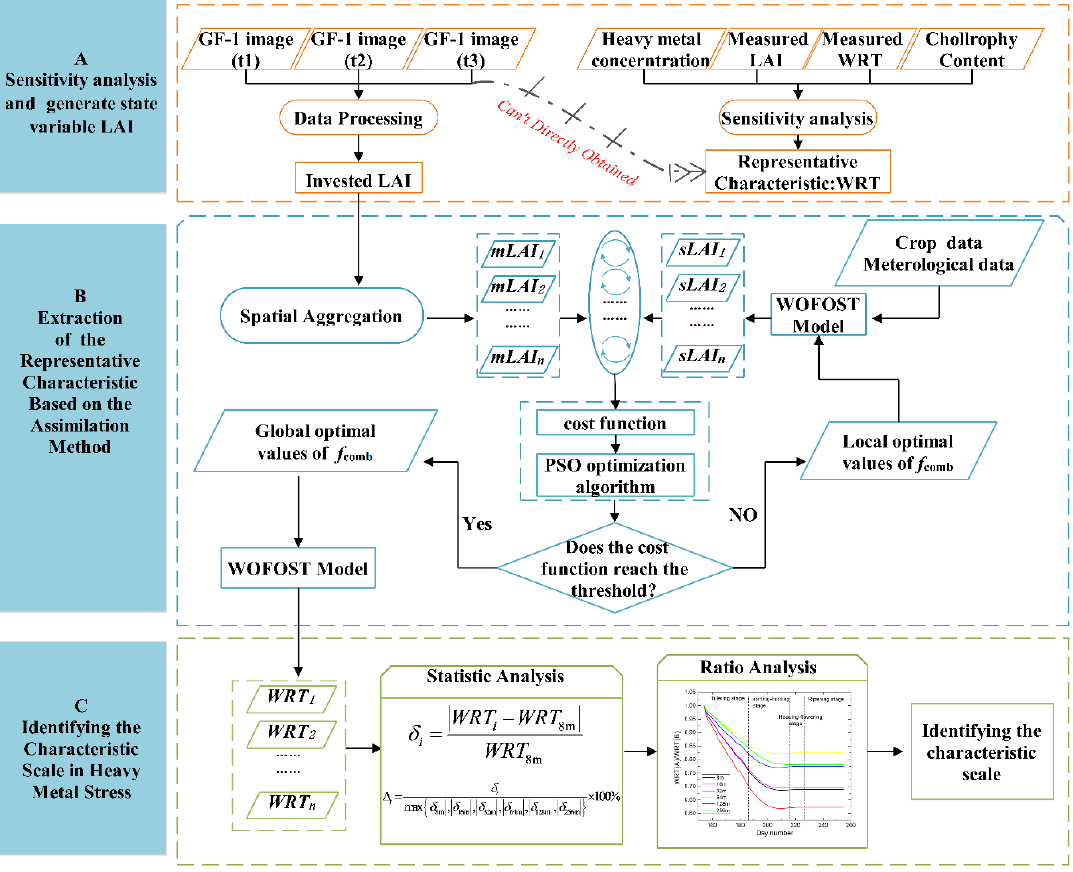
Figure 2. General flow chart for identifying the characteristic scale in rice heavy metal stress monitoring based on the RS-WOFOST framework.